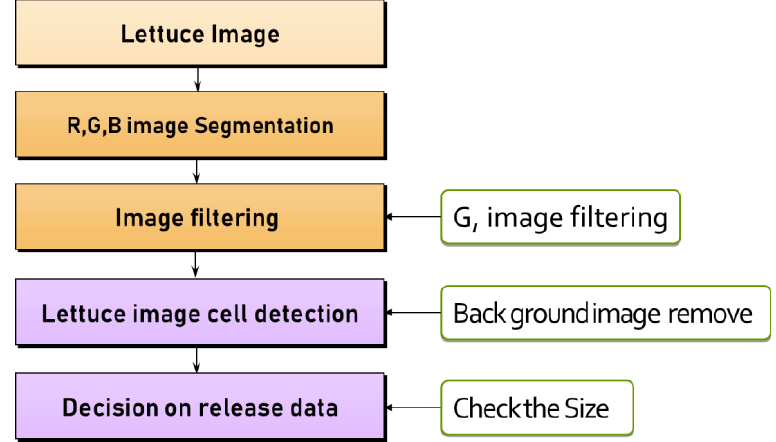
Figure 13. Flow chart of plant growth information extraction image recognition algorithm.